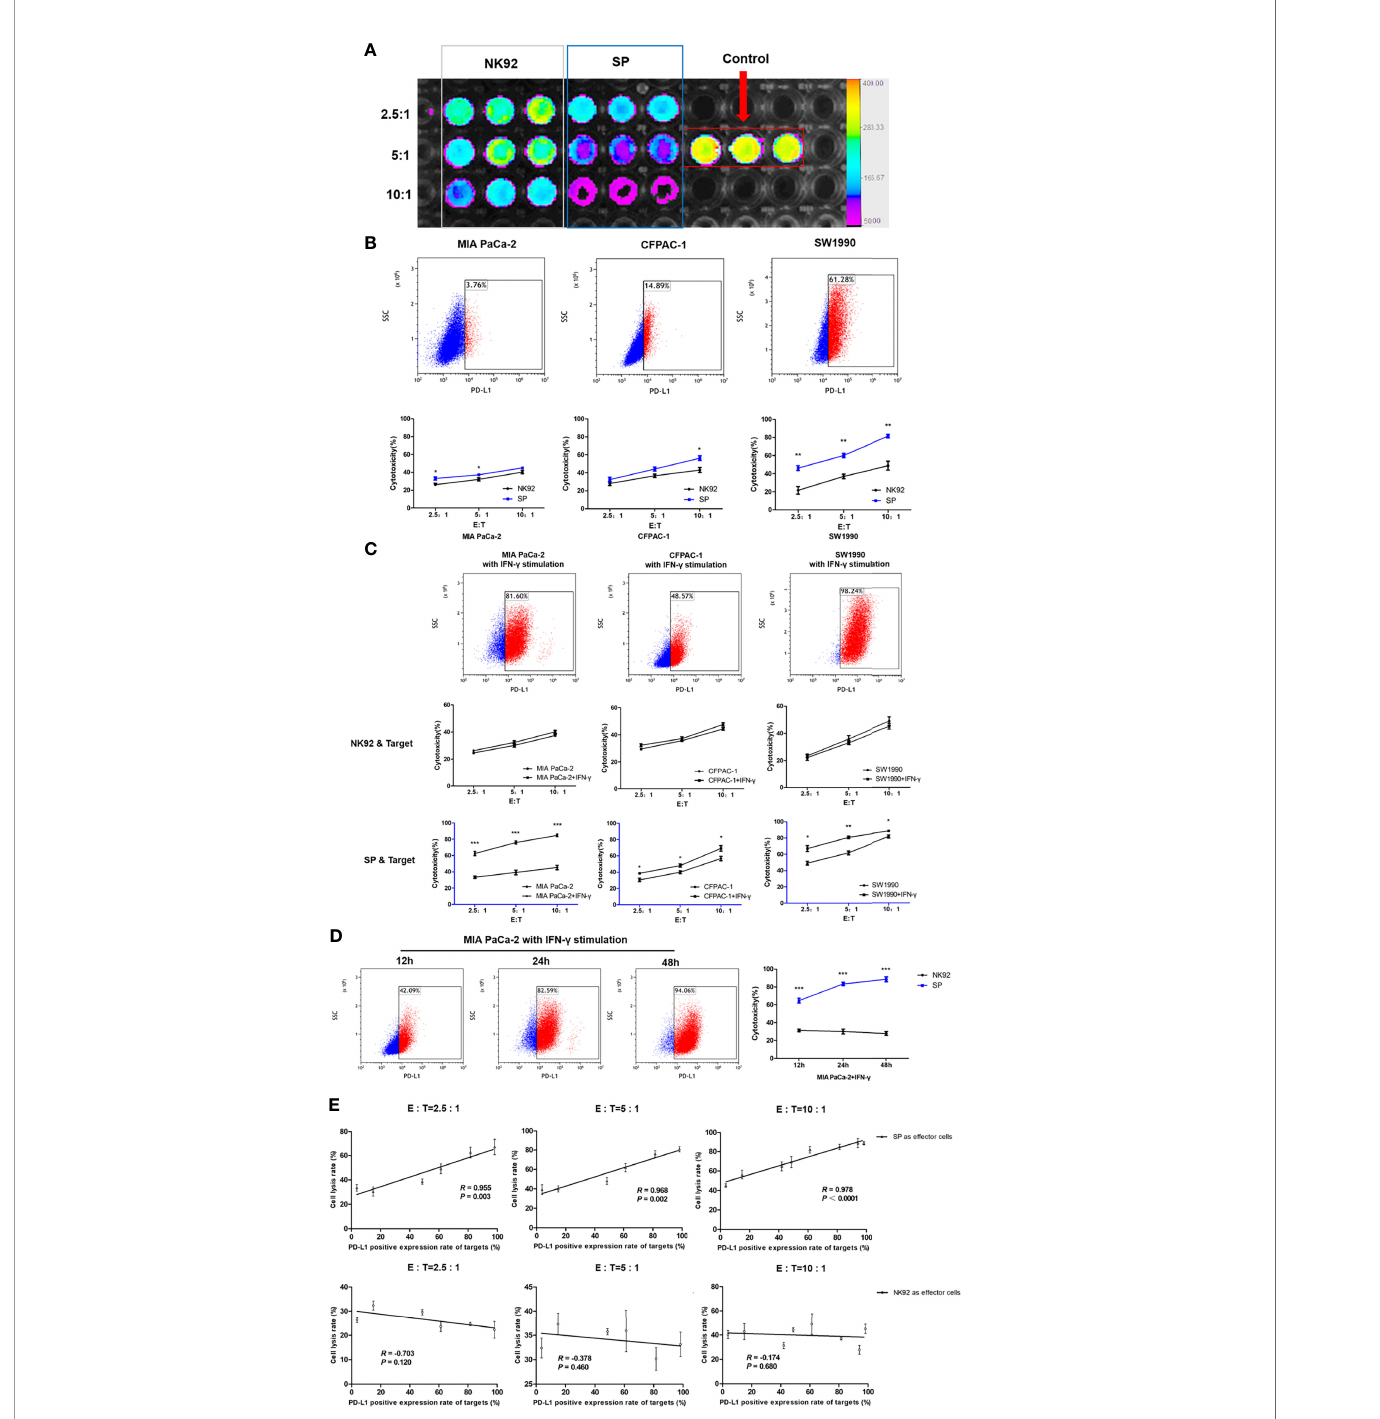
FIGURE 3 | Enhanced cytotoxicity of SP cells against both innate and IFN- g -induced PD-L1-positive PDAC cells in a PD-L1 dose-dependent manner. (A) Cytotoxicity of SP or NK92 cells against SW1990 cells was measured by bioluminescence imaging after a 12-hour co-culture. (B) Expression of programmed cell death ligand 1(PD-L1) in three Pancreatic ductal adenocarcinoma (PDAC) cell lines (MIA PaCa-2, CFPAC-1, SW1990) was detected by FCM, and the lysis rate of SP and NK92 cells against each cell line was analyzed. (C) The three PDAC cell lines were stimulated with 5 ng/mL IFN- g for 24 hours, the expression of PD-L1 in each cell line and the cytotoxicity of SP or NK92 cells against each cell line were detected. (D) MIA PaCa-2 cells were stimulated with 5 ng/mL IFN- g for 12, 24, and 48 hours, to induce the expression of PD-L1 and the cytotoxicity achieved by SP or NK92 cells in co-cultures were assessed. (E) A correlation analysis between the cytotoxicity and target cell PD-L1 level. All summary data are indicated as mean ± SEM (n = 3). *P < 0.05, **P < 0.01 and ***P <